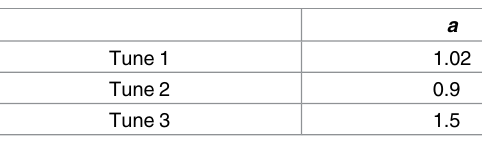
Table 3. Values of a and b related to Fig